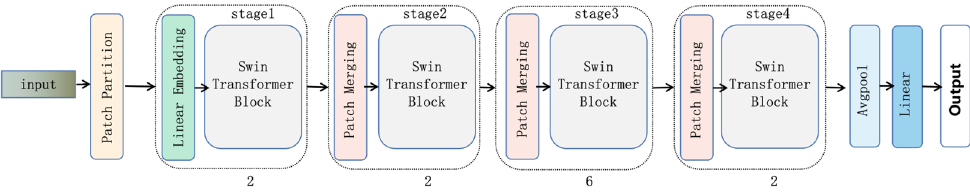
Figure 5. Swin transformer module diagram.